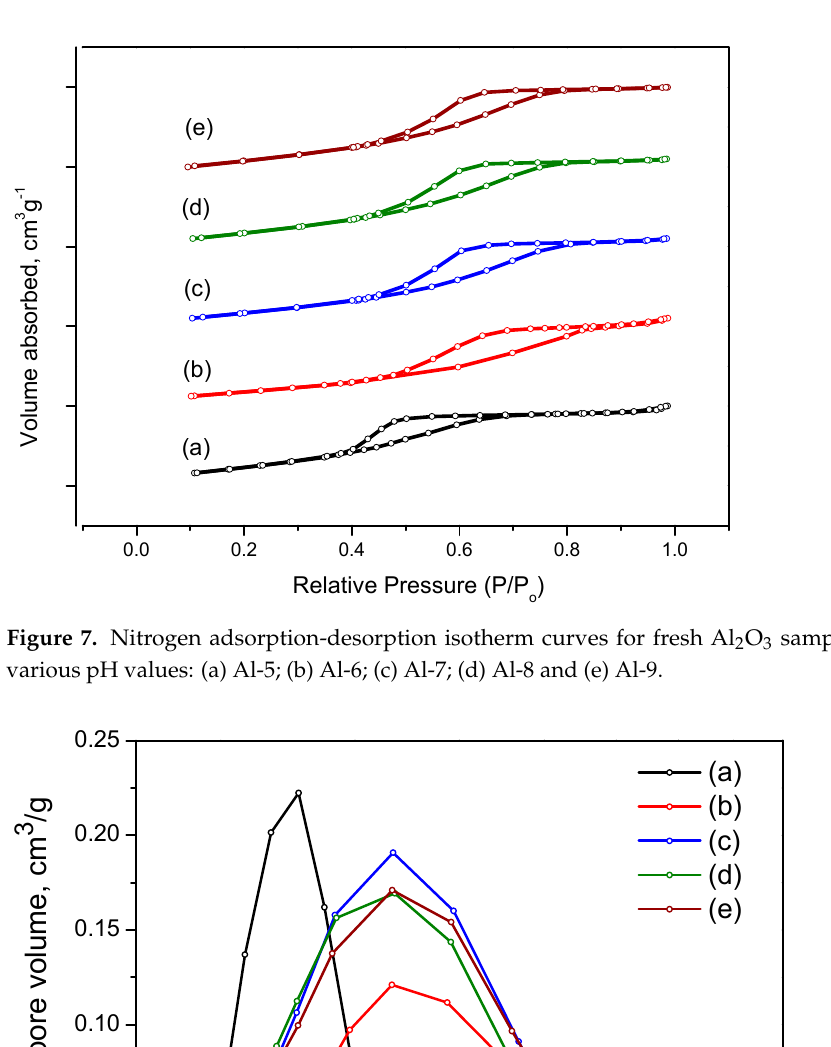
( B ) Figure 6. X-ray patterns of the samples ( A ): (5) Al-5; (6) Al-6; (7) Al-7; (8) Al-8; (9) Al-9 and the dependence of the crystal size on the pH of the precipitation ( B ). The N 2 adsorption isotherms (Figure 7) for all samples correspond to type IV with the presence of the hysteresis loop of IUPAC type H2, indicating the predominance of ink bottle pores. For the samples obtained at pH = 6–9, the adsorption and desorption iso- therms are practically indistinguishable, indicating the similarity of pore size and volume.